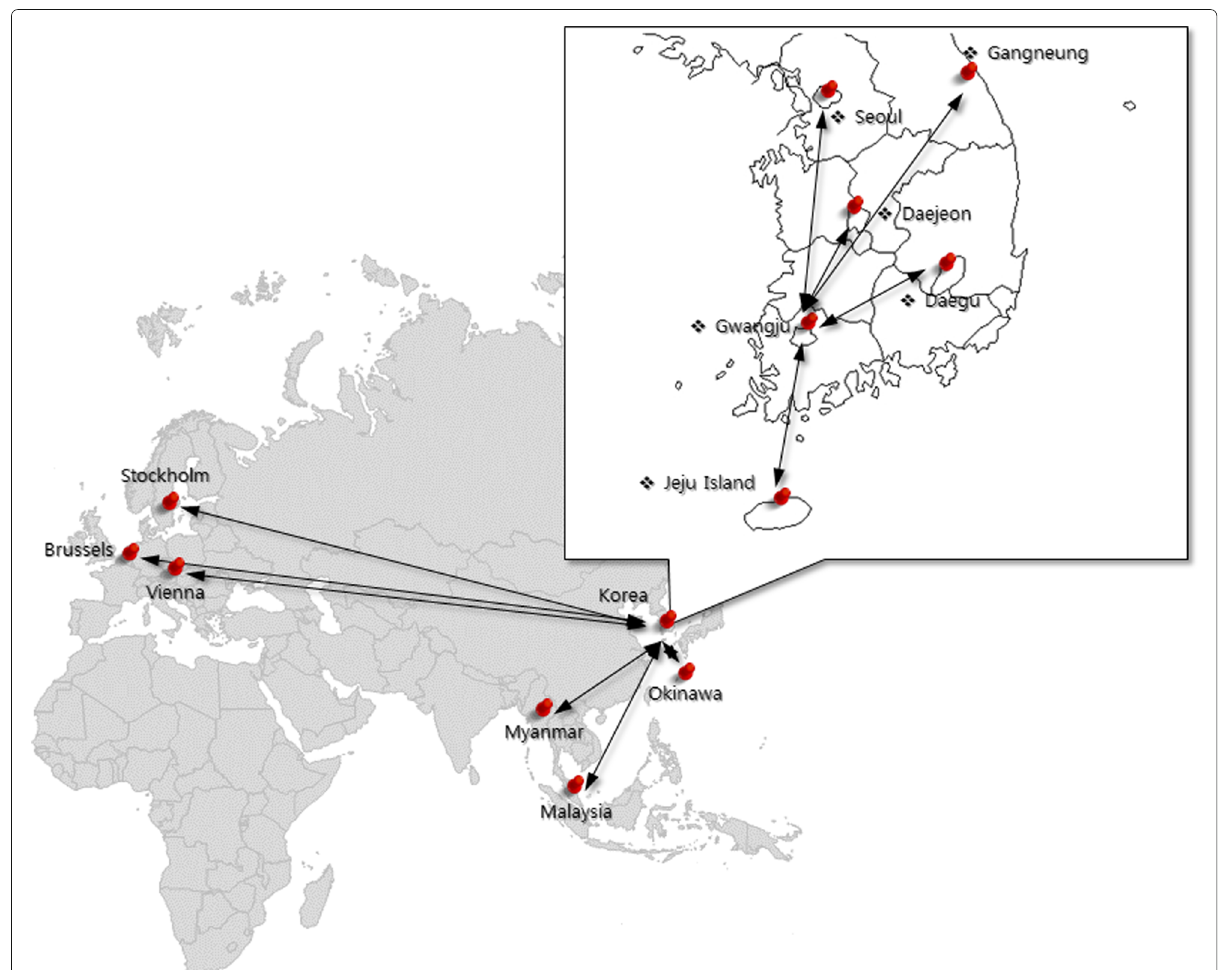
Fig. 11 Global and domestic verification experiment: locations and connectivity